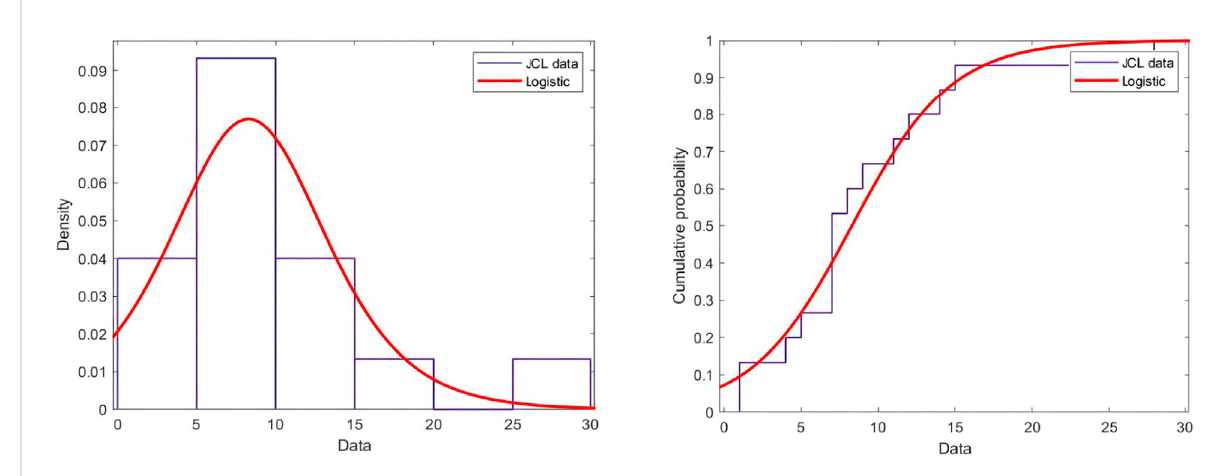
FIGURE 9 Probability density plot and cumulative distribution plot of the logistic distribution.